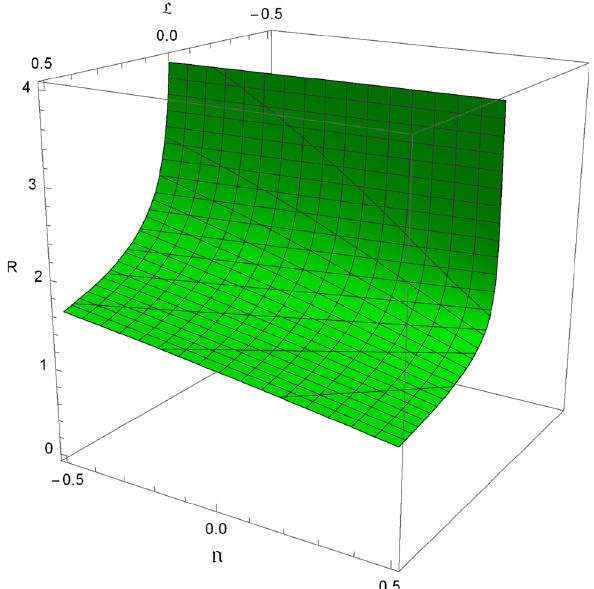
Fig. 15 The variation of D s versus typical values of the M ( u ) and 1 N c ( u ) parameters for the cosmological constant-like background Fig. 16 The variation of R versus typicalvalues of the L and N param- eters in (47) for the cosmological constant-like background. We have set M = 1 without loss of